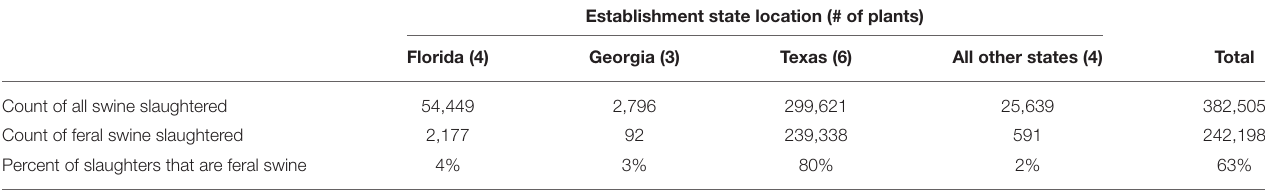
TABLE 1 | Counts of all swine slaughtered and proportion of feral swine at 17 FSIS inspected slaughter establishments that slaughtered feral swine, 2017–2019.